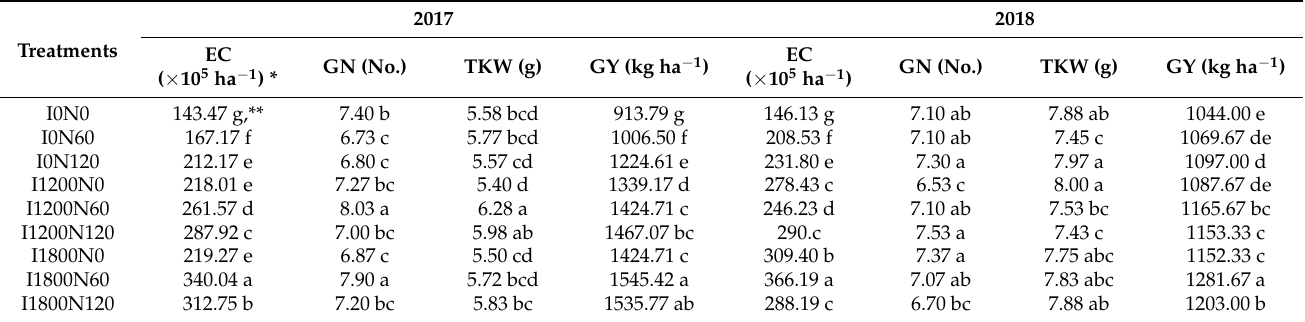
Table 3. Response of yield components to different irrigation and nitrogen treatments in the 2017 and 2018 growing seasons.